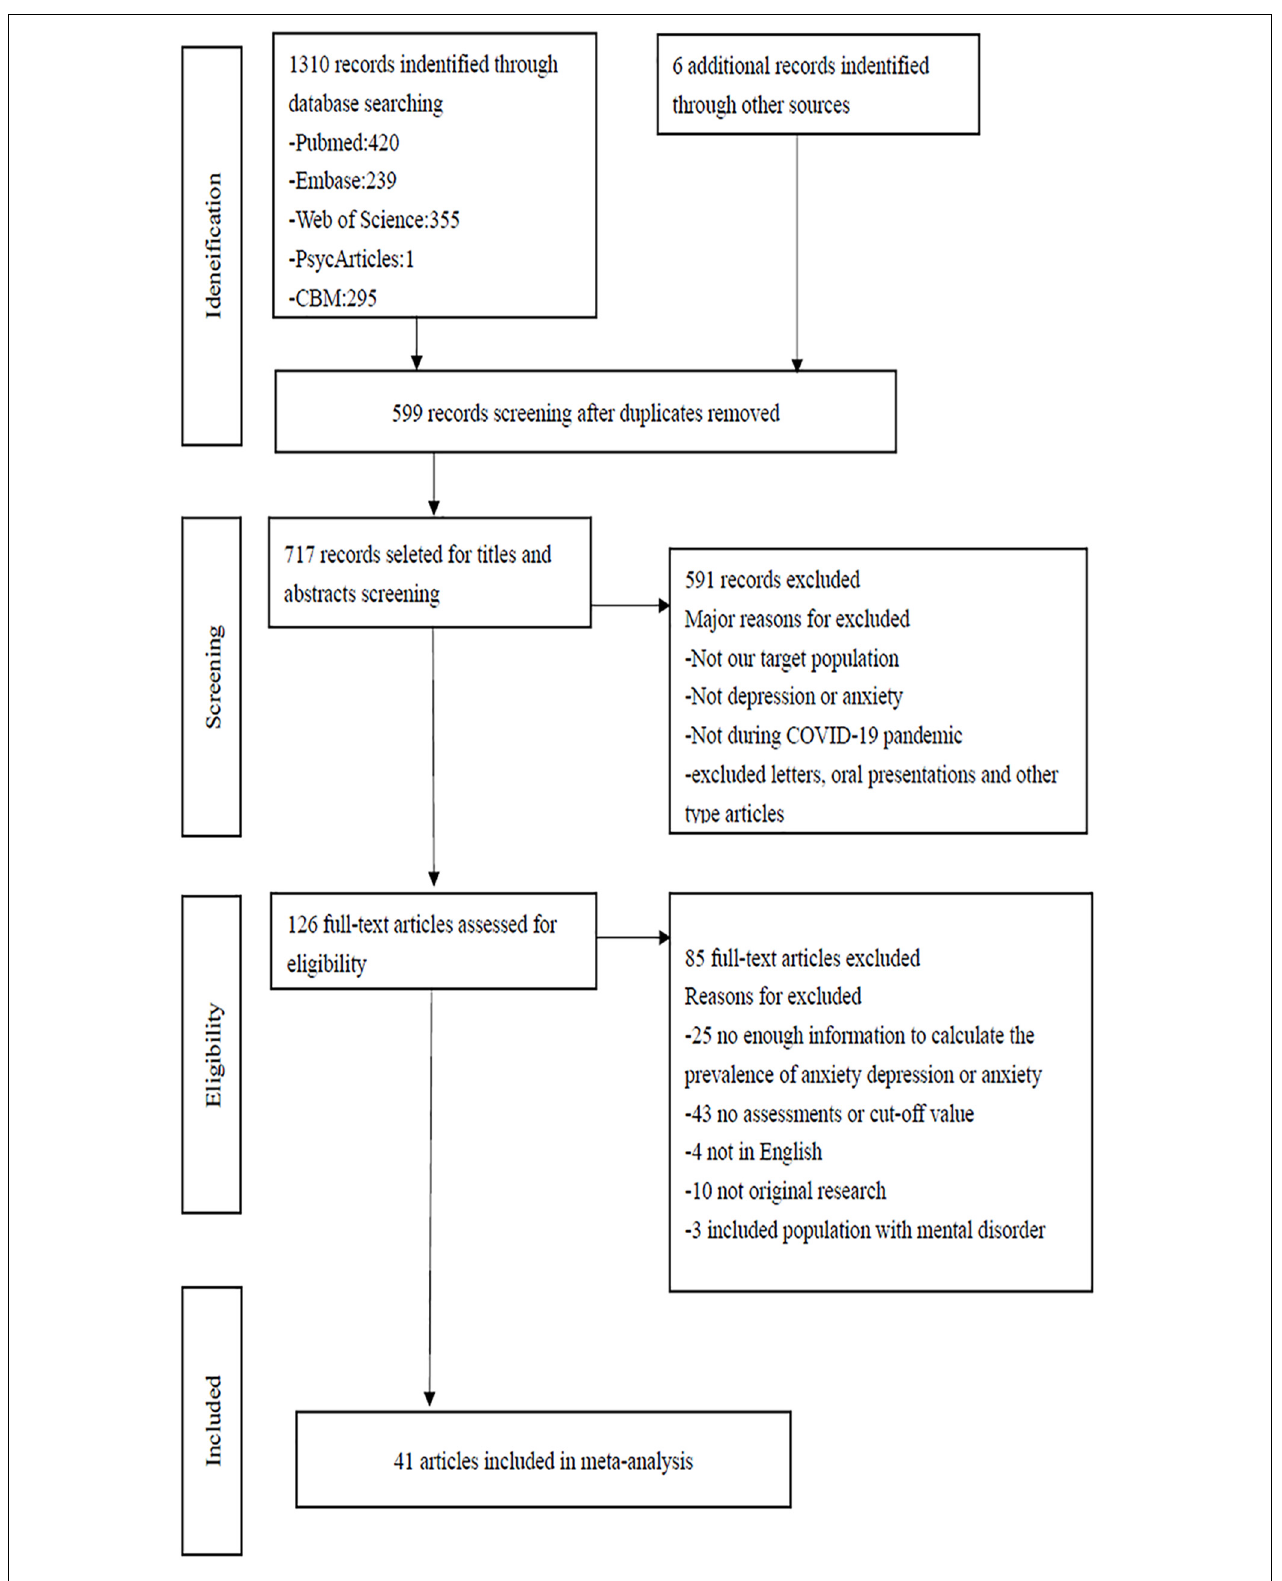
FIGURE 1 | Flow chart of study